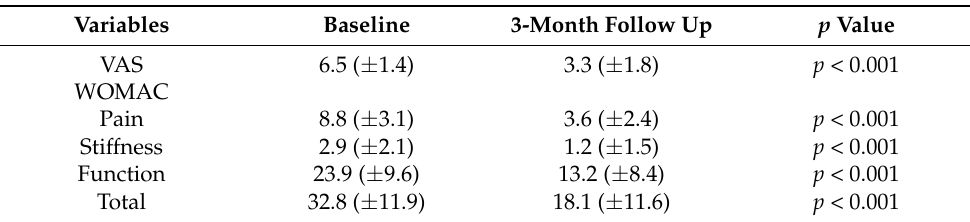
Table 2. VAS and WOMAC index variables at baseline and follow up in patients with unilateral primary knee